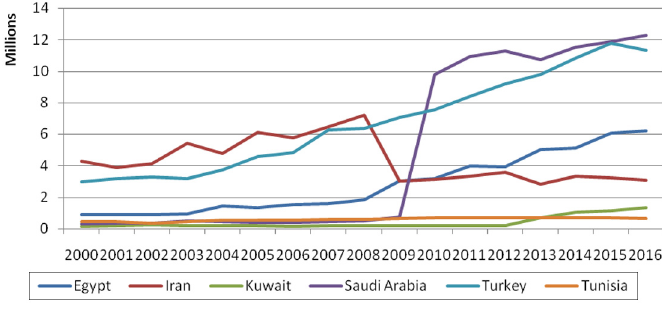
Figure 3. GERD Evolution in MENA countries,